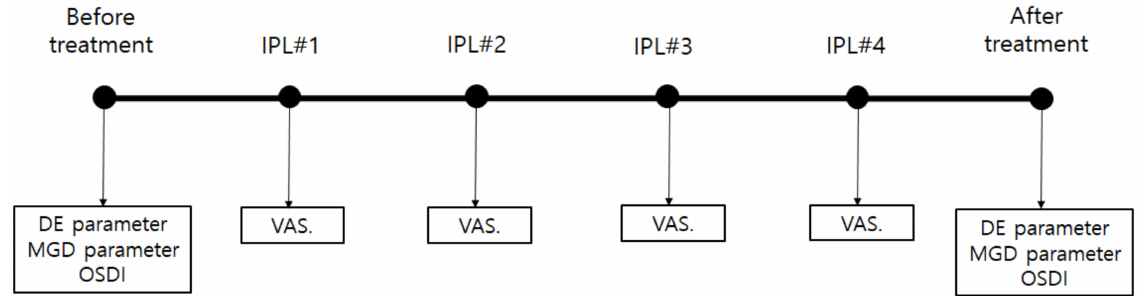
Figure 1. Brief schedule of IPL treatment and clinical evaluations. DE and MGD parameters and the OSDI are obtained before the first IPL treatment and after the fourth IPL treatment. Abbreviations: IPL, intense pulsed light; DE, dry eye; IPL#1, first IPL treatment; IPL#2, second IPL treatment; IPL#3, third IPL treatment; IPL#4, fourth IPL treatment; MGD, Meibomian gland dysfunction; OSDI, ocular surface disease index; VAS, visual analog